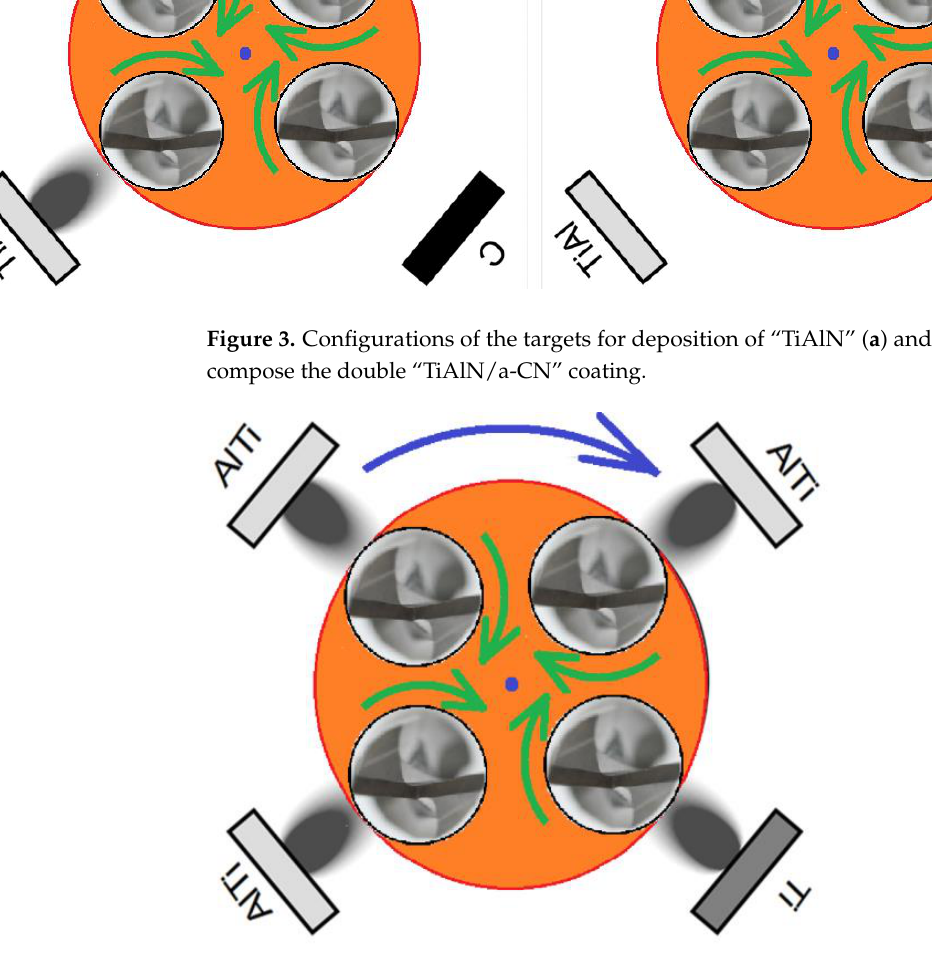
Figure 4. Configurations of the multi layer “TiN/AlTiN” coating targets.